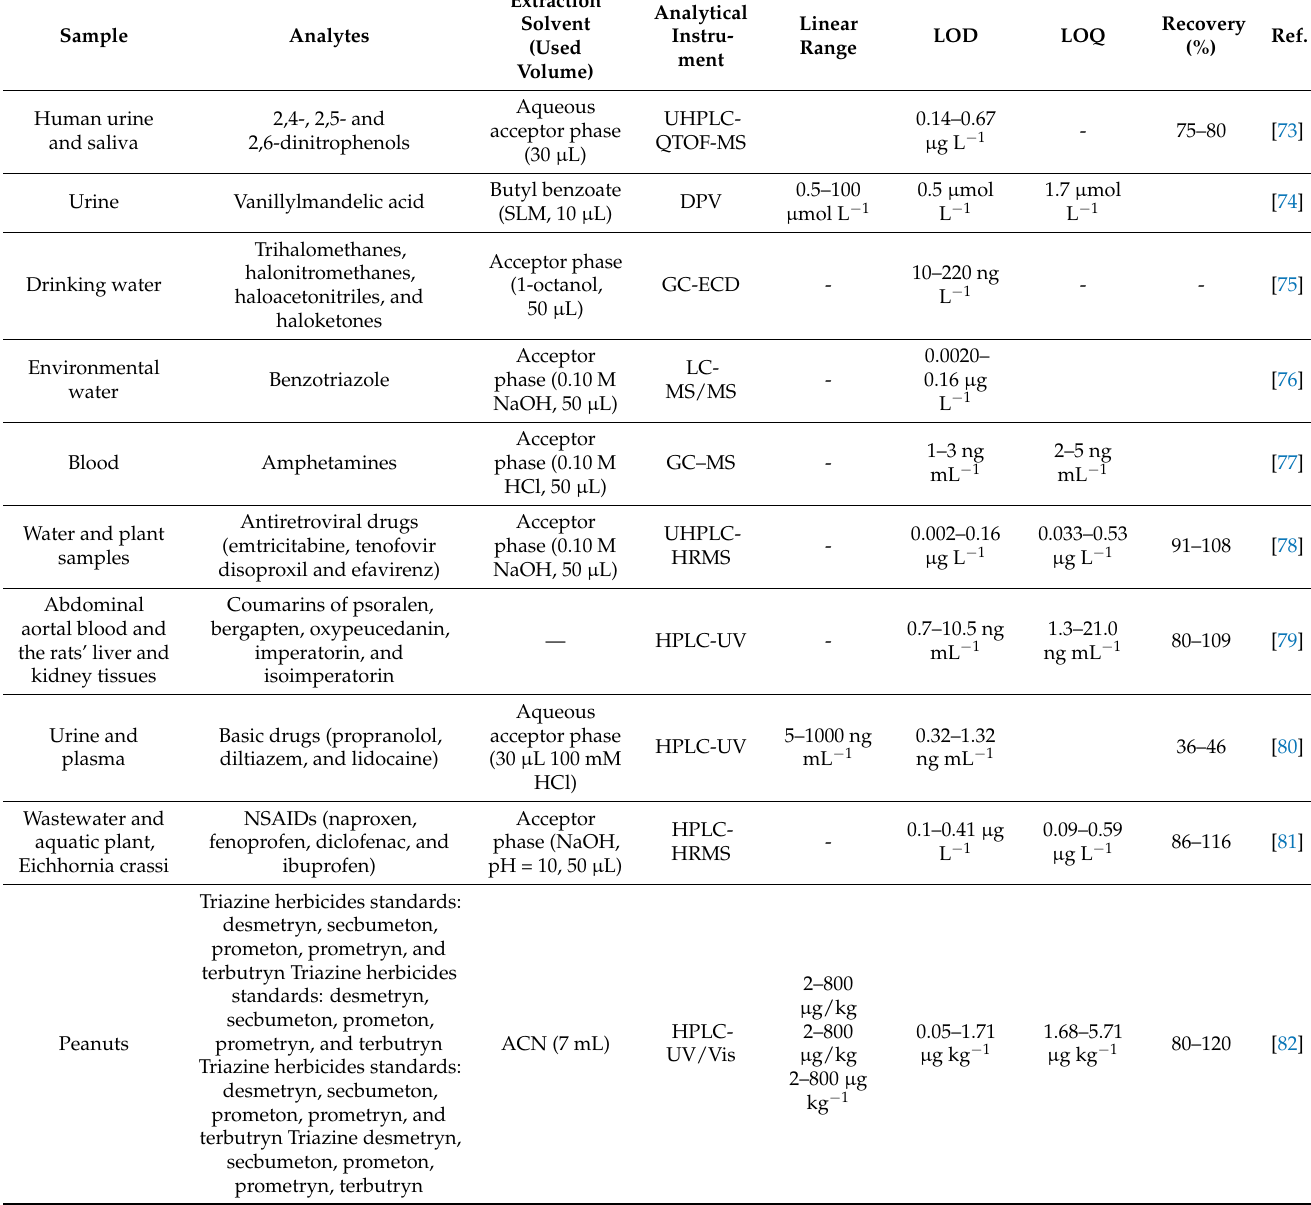
Table 4. A summary of the selected application examples of